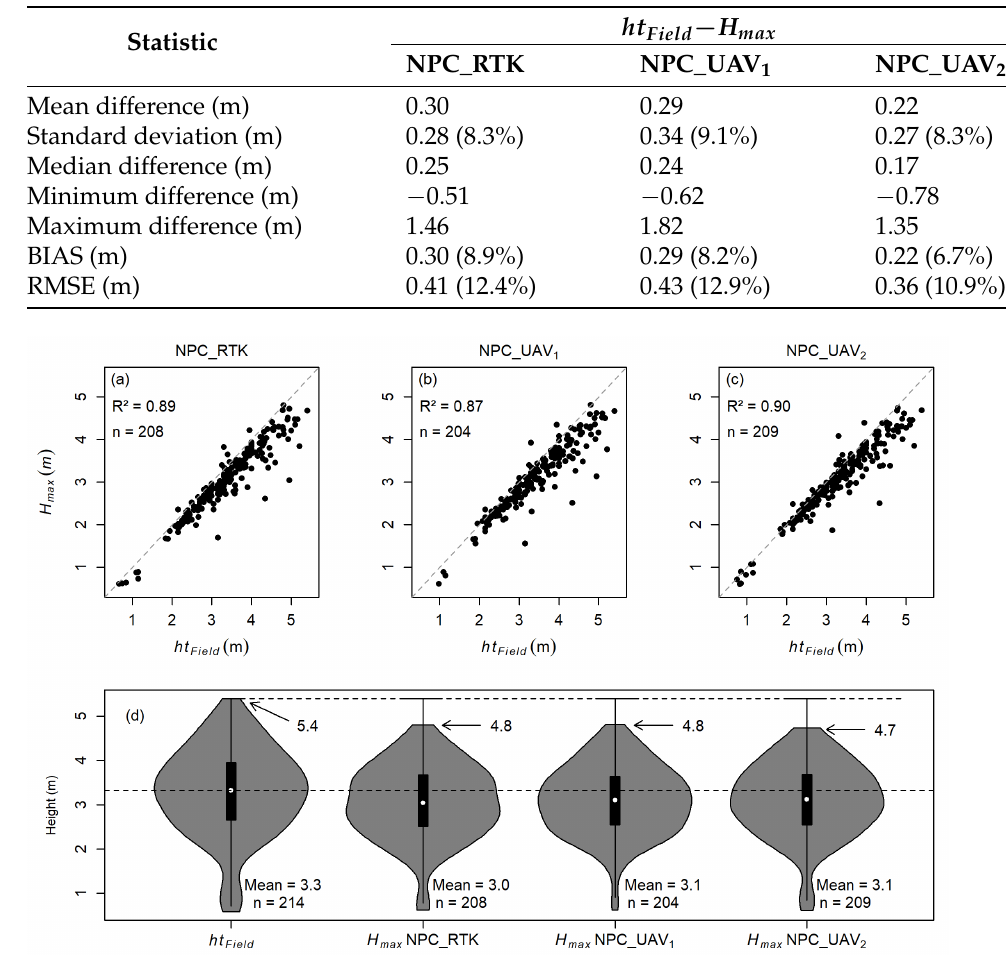
Figure 4. Scatterplots ( a – c ) and boxplots ( d ) of observed ( ht Field ) versus estimated ( H max ) tree heights from UAV photogrammetry, considering three normalized point clouds (NPC). The dashed line in ( d ) represents the mean value of ht Field